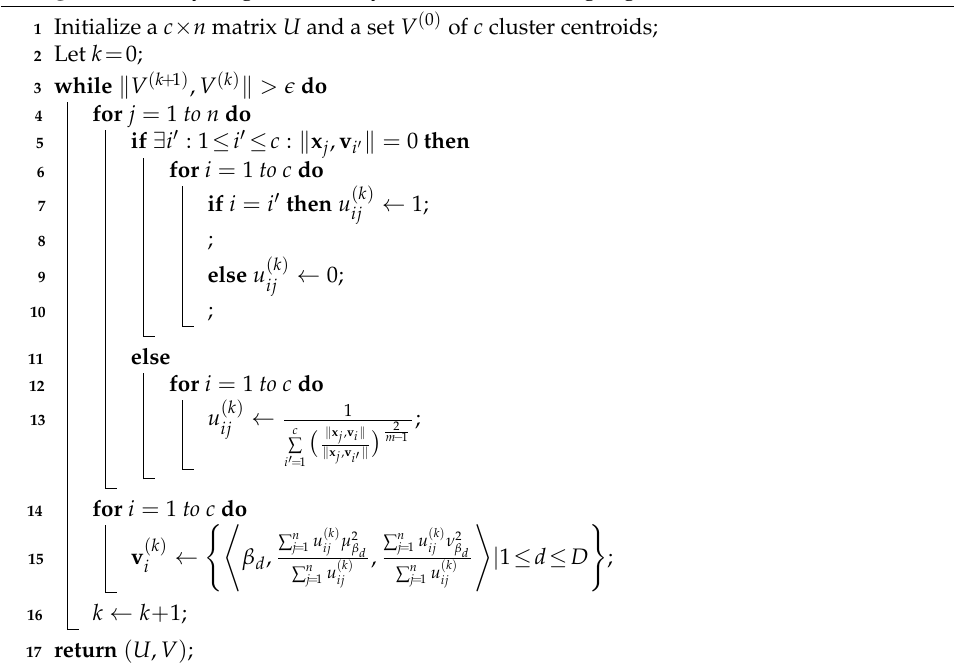
Algorithm 1: Pythagorean fuzzy c -means clustering